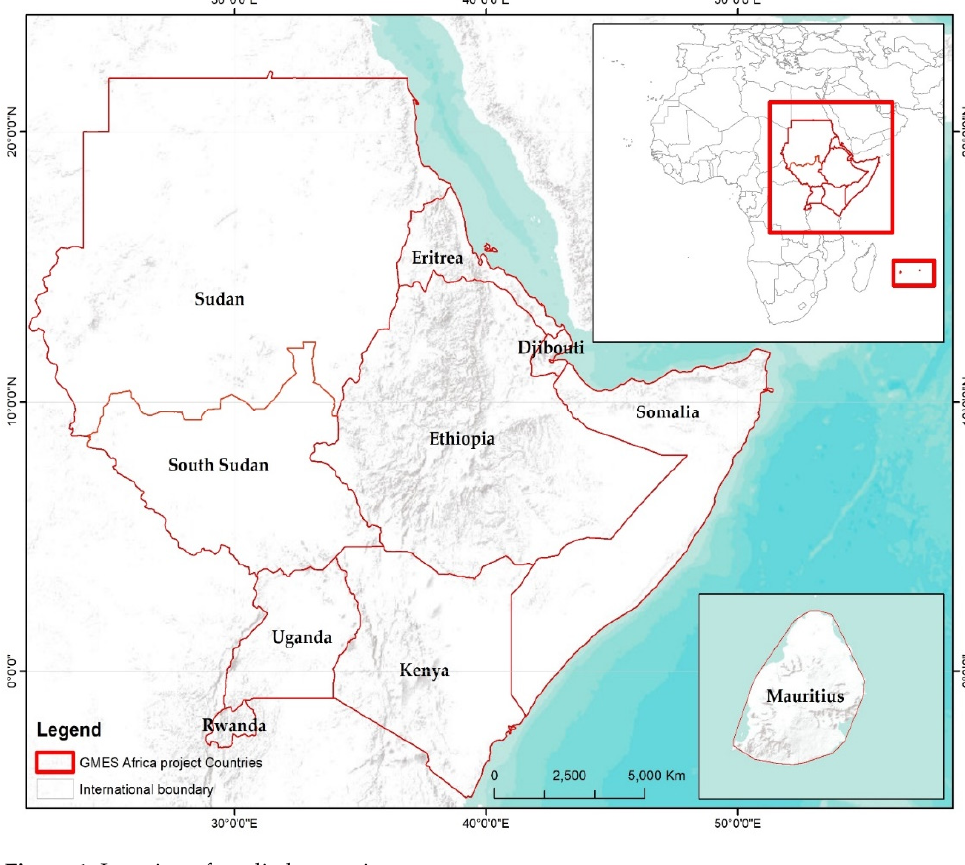
Figure 1. Location of studied countries. Table 1. List of datasets and associated sources.